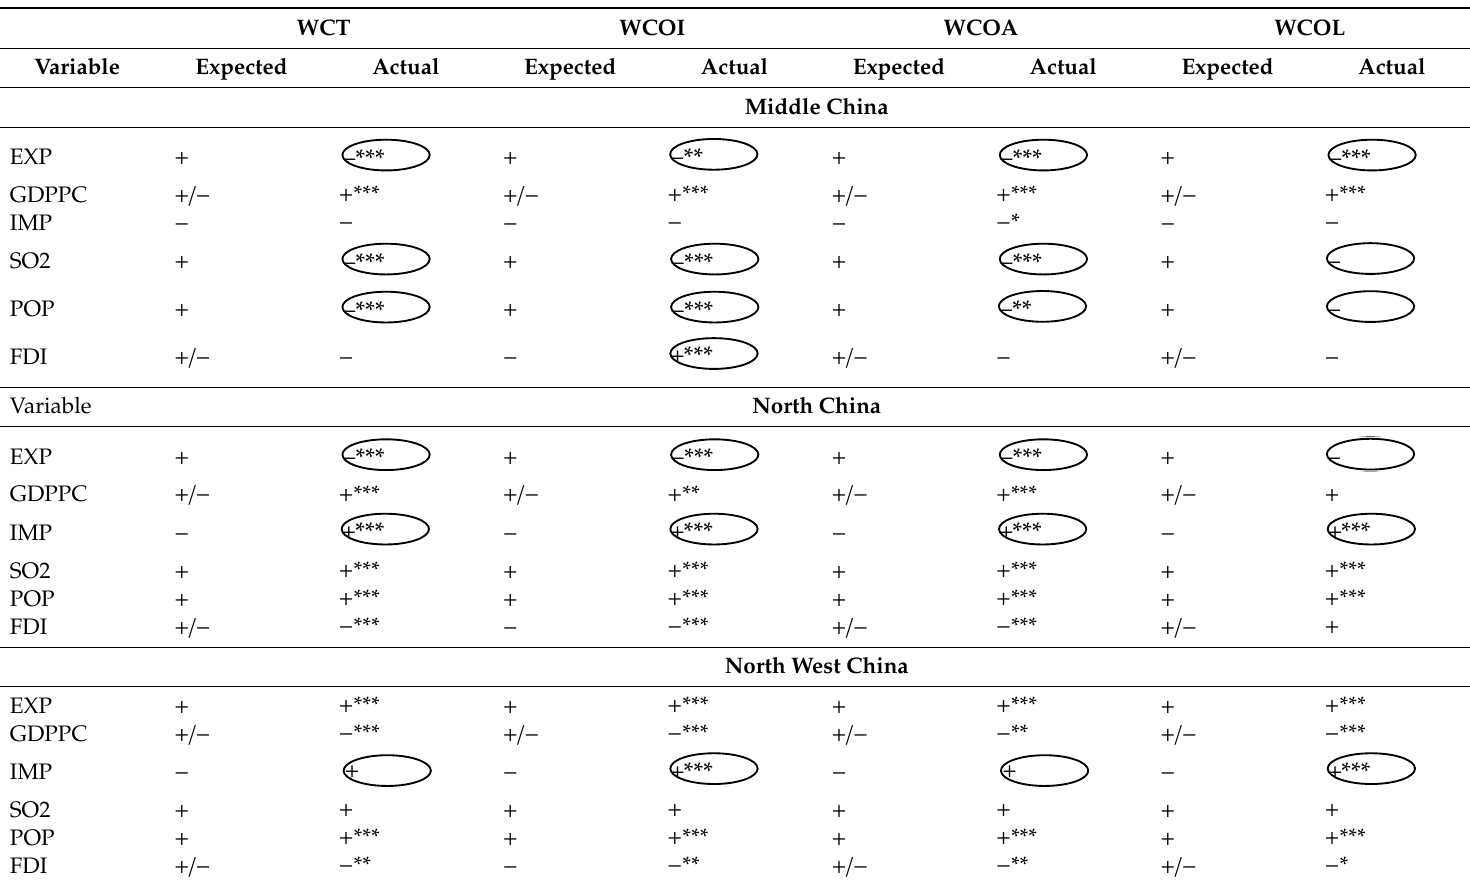
Table 9. FMOLS estimates and the sign comparison—expected versus actual.